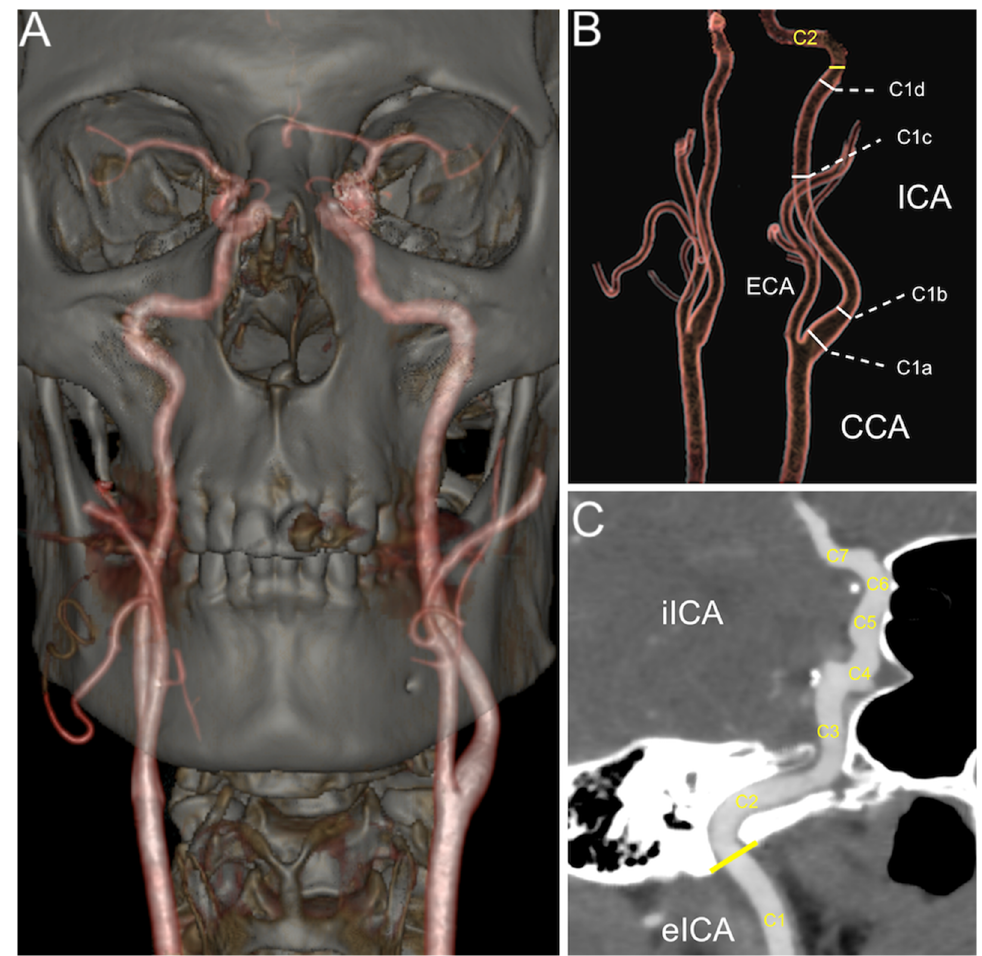
Figure 1. ( A ) VRT image of a carotid CT angiography; ( B ) VRT illustration of the cervical ICA measurement landmarks (carotid bulb—C1a; post-bulbar dilation—C1b; at the middle of C1—C1c; and below its entrance into carotid foramen—C1d) and representation of the carotid foramen position (yellow line); ( C ) oblique MIP image demonstrating set measurement points in the iICA (C2–C7). Abbreviations: CCA—common carotid artery; ICA—internal carotid artery; eICA—extracranial (cervical) part of ICA; iICA—intracranial part of ICA; ECA—external carotid artery; VRT—volume rendering technique; MIP—maximum intensity projection.